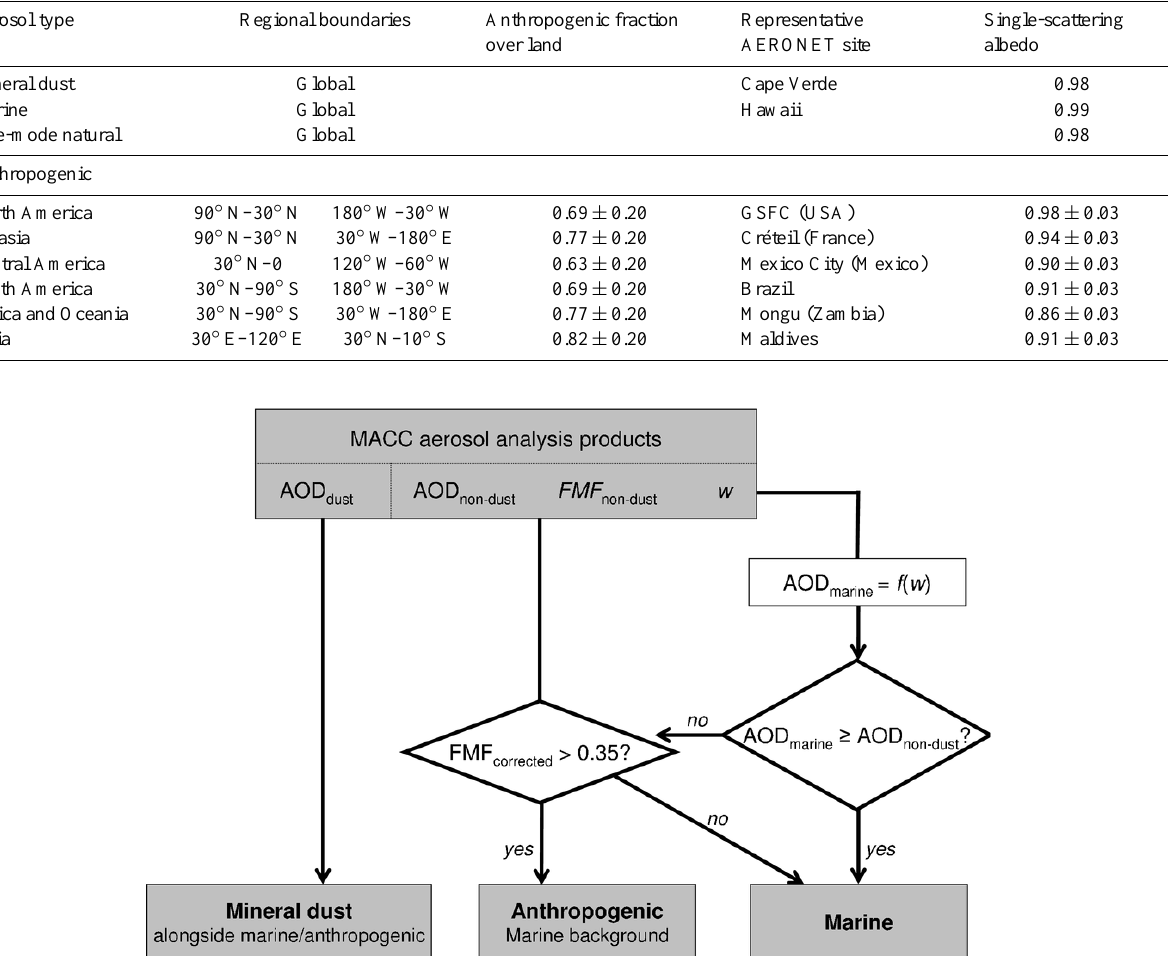
Table 1. Parameters used to derive the anthropogenic aerosol optical depth over land and to prescribe aerosol optical properties over ocean and land surfaces for the four aerosol components. The single-scattering albedo is given at 0.55µm. Optical properties for the anthropogenic aerosol component are prescribed regionally. Representative AERONET sites refer to the sites studied by Dubovik et al. (2002). For the other components, optical properties are prescribed globally. Standard deviations are used in the Monte-Carlo uncertainty analysis described in Sect. 7.